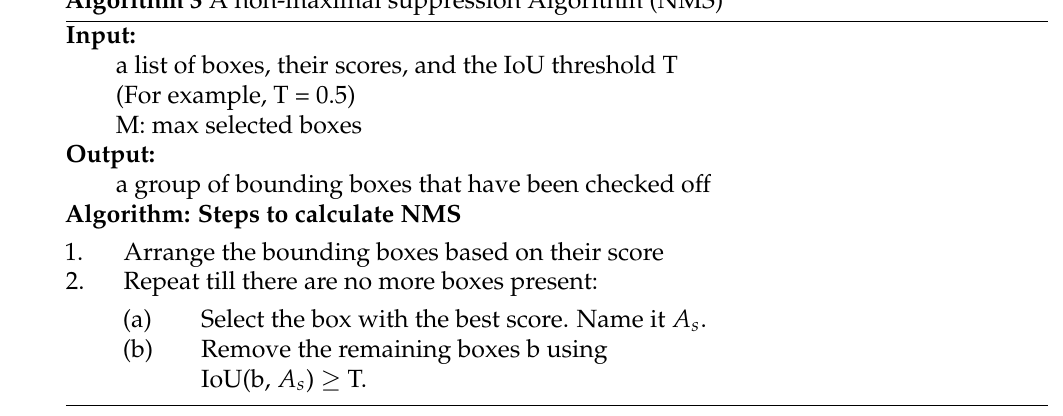
Algorithm 3 A non-maximal suppression Algorithm